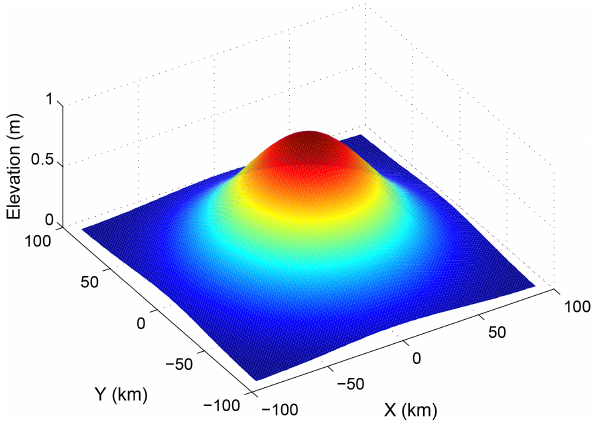
Figure 3. Gaussian basis